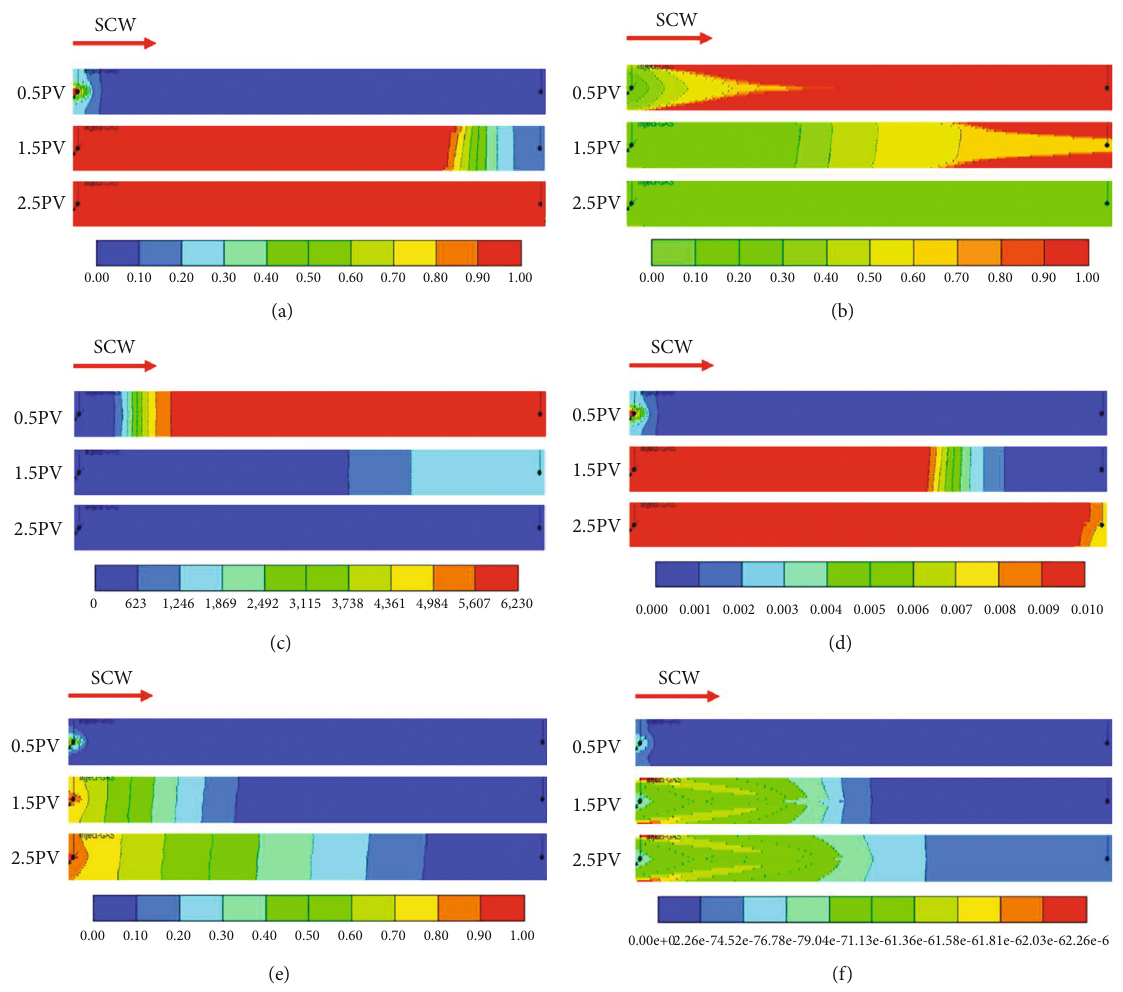
Figure 9: Simulation results of SCW fl ooding for distributions of (a) SCW mole fraction, (b) oil saturation, (c) oil viscosity, and (d) gas mole fraction and distributions of (e) light oil mole fraction and (f) coke at di ff erent injection